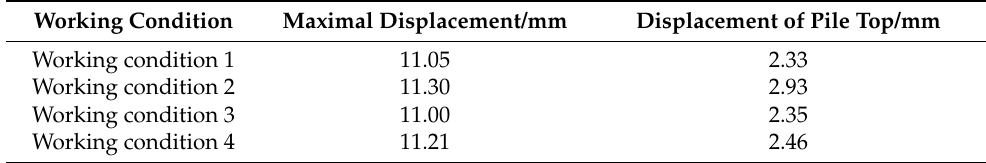
Table 4. Displacement of the supporting structure under different working